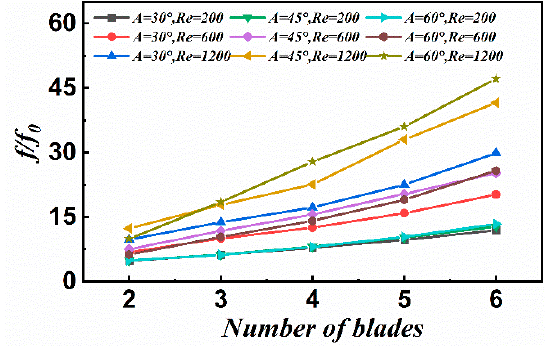
Figure 8 Variations of f/f o with blade number at P = 3 mm. Figure 8. Variations of f/f o with blade number at P = 3